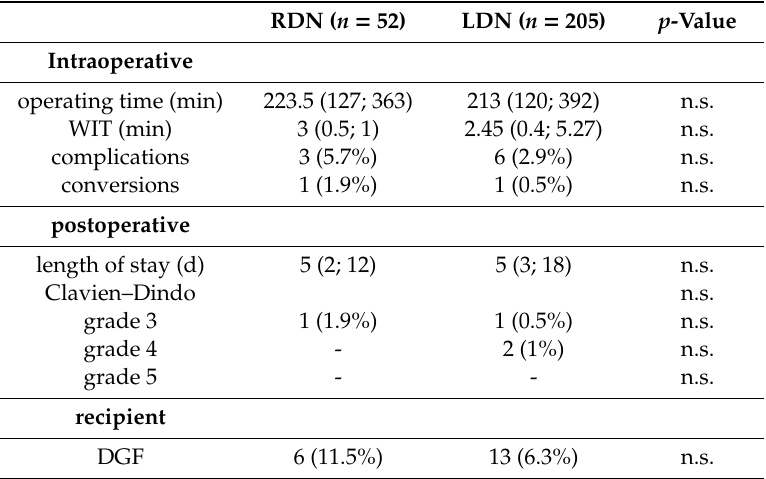
Table 2. Outcomes of 257 donor nephrectomies.